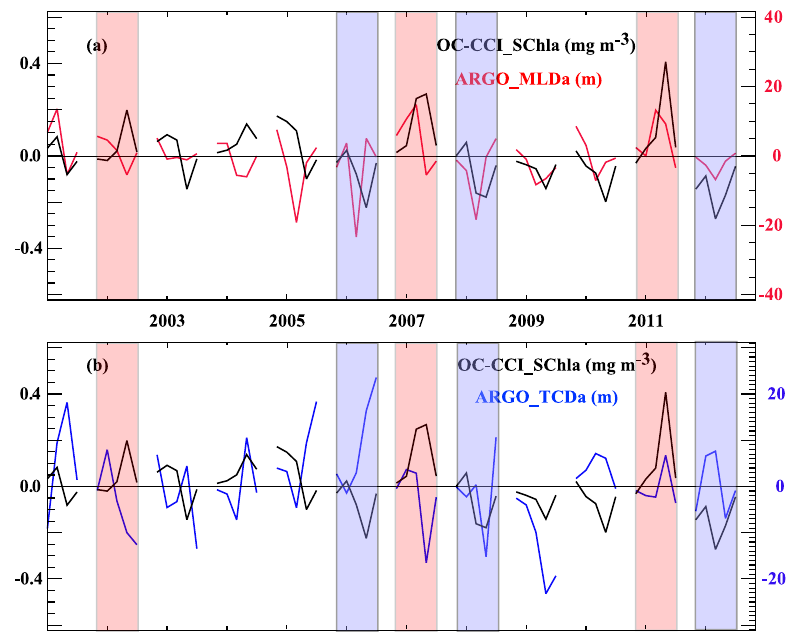
Figure 8. Observed monthly time series of NAS-box-averaged (a) SChl and MLD and (b) SChl and TCD anomalies in winter over the 2002–2013 period. The red (blue) shadings highlight the winters of strong (weak) blooms used in the composite plots of Fig.